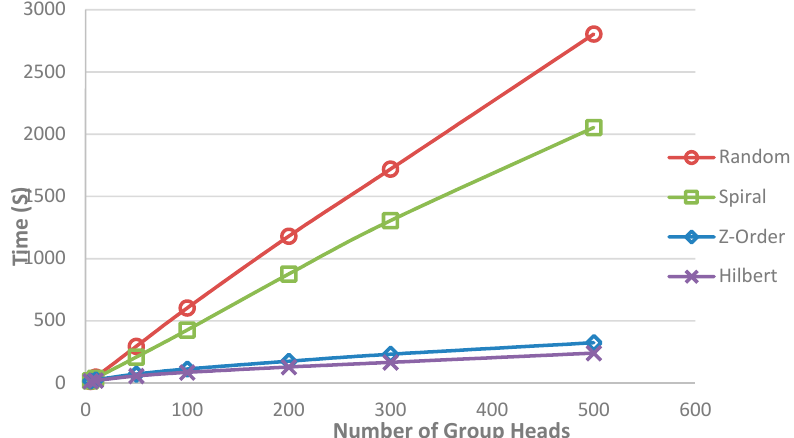
Figure 3. Comparing the total time required of by the mobile sink to collect data from all group heads ( GHs ) using different orderings of GHs (different collection paths).